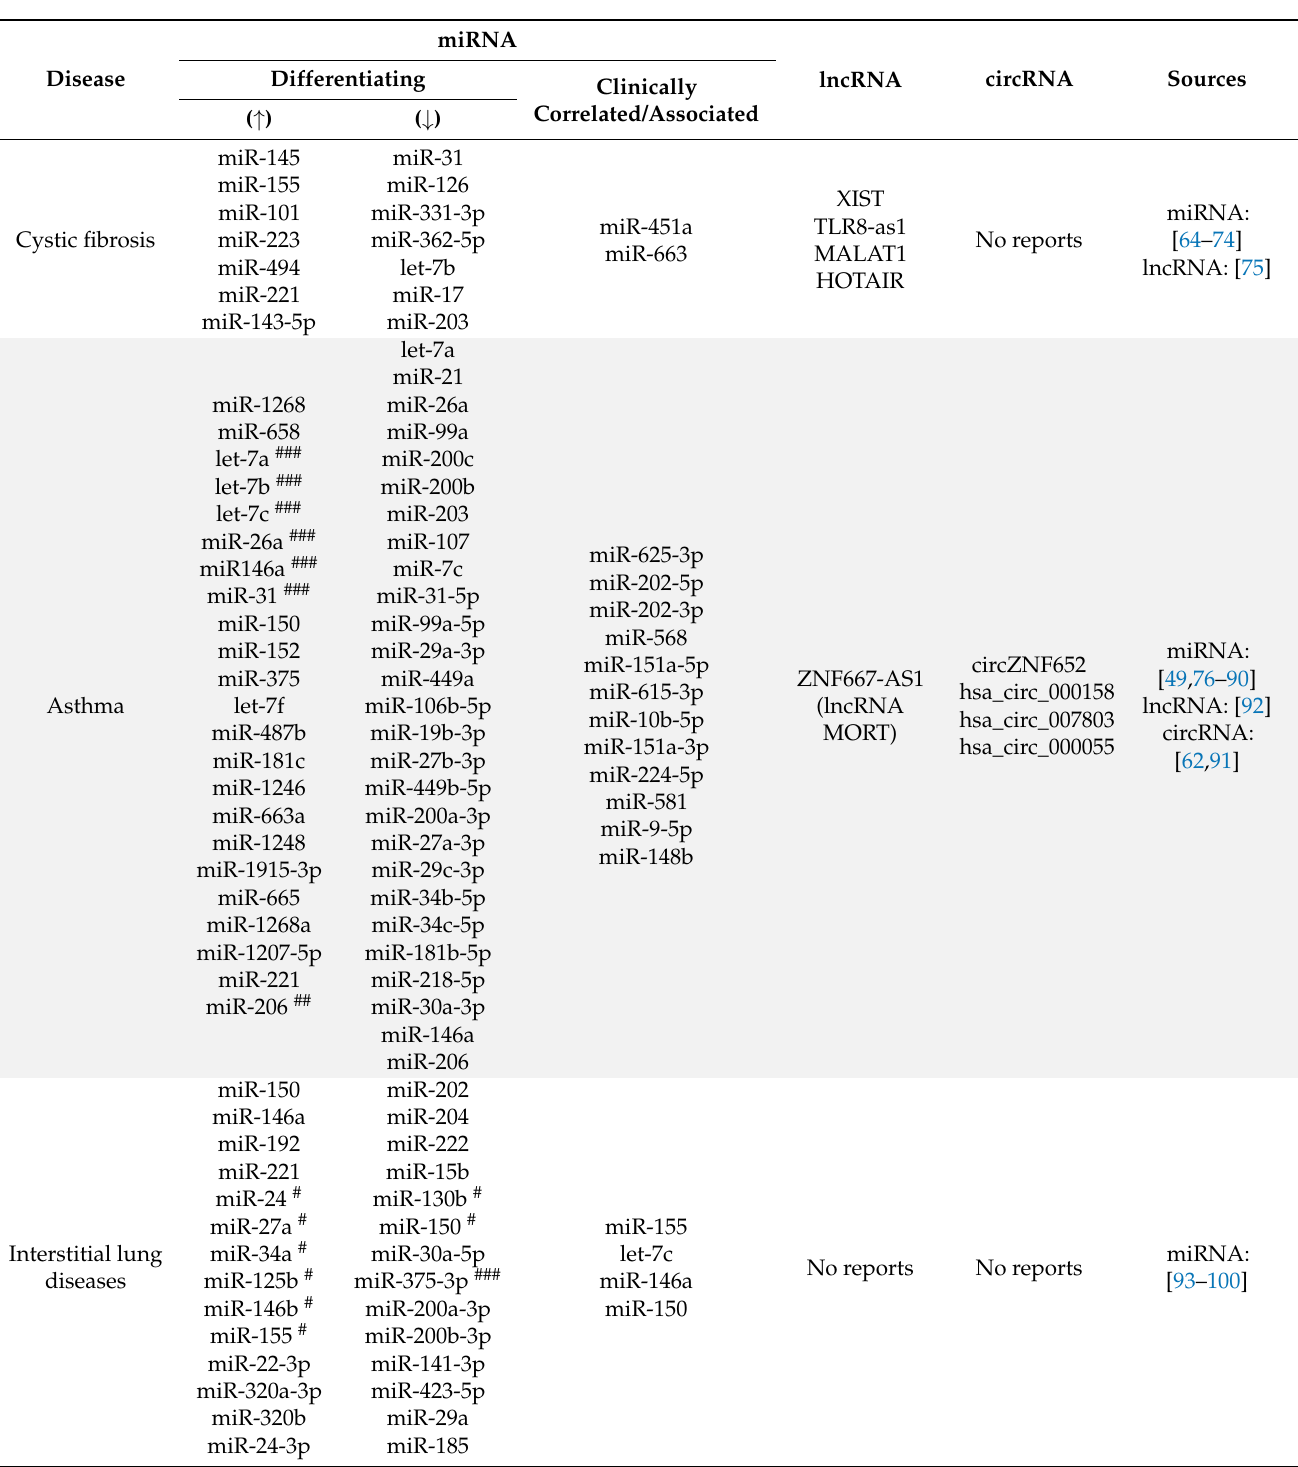
Table 3. Non-coding RNAs investigated in bronchoalveolar lavage fluid (BALF) and bronchial brushing (BB) in three examples of respiratory diseases. miRNAs are classified accordingly to their reported nature as disease-differentiating or associated with the clinical